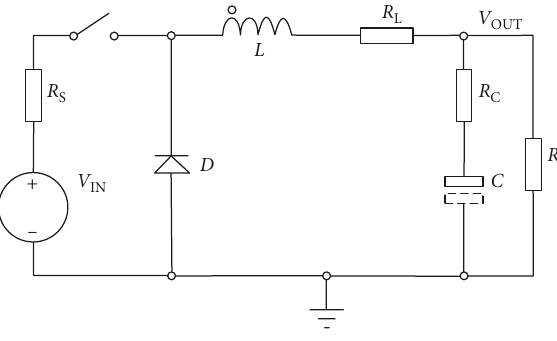
Figure 1: Conventional buck convertor.